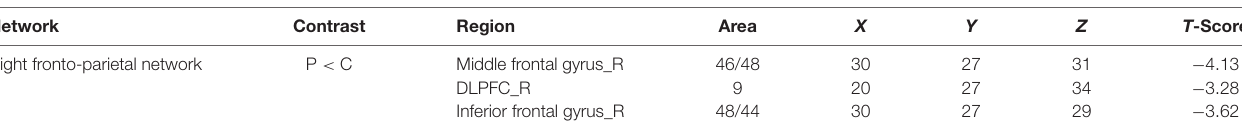
TABLE 3 | Local maxima of regions with altered connectivity within the right frontoparietal network (rFPN). Network Contrast Region Area Right fronto-parietal network P < C Middle frontal gyrus_R